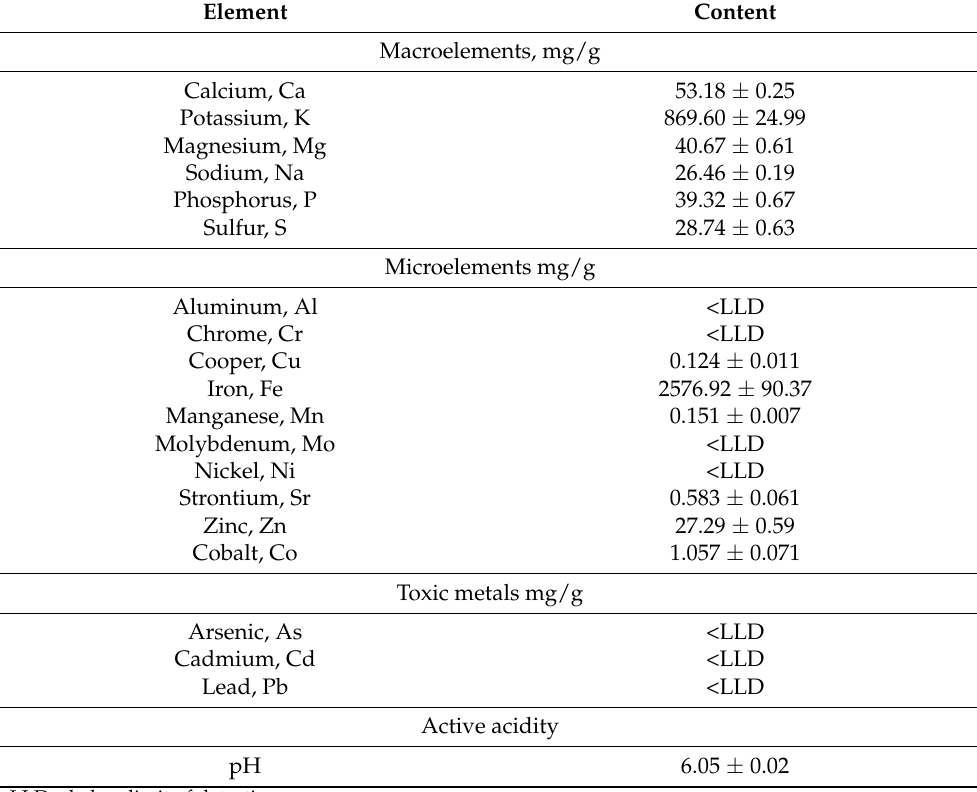
Table 2. Multielemental composition of the botanical biogranulate (average ± SD).